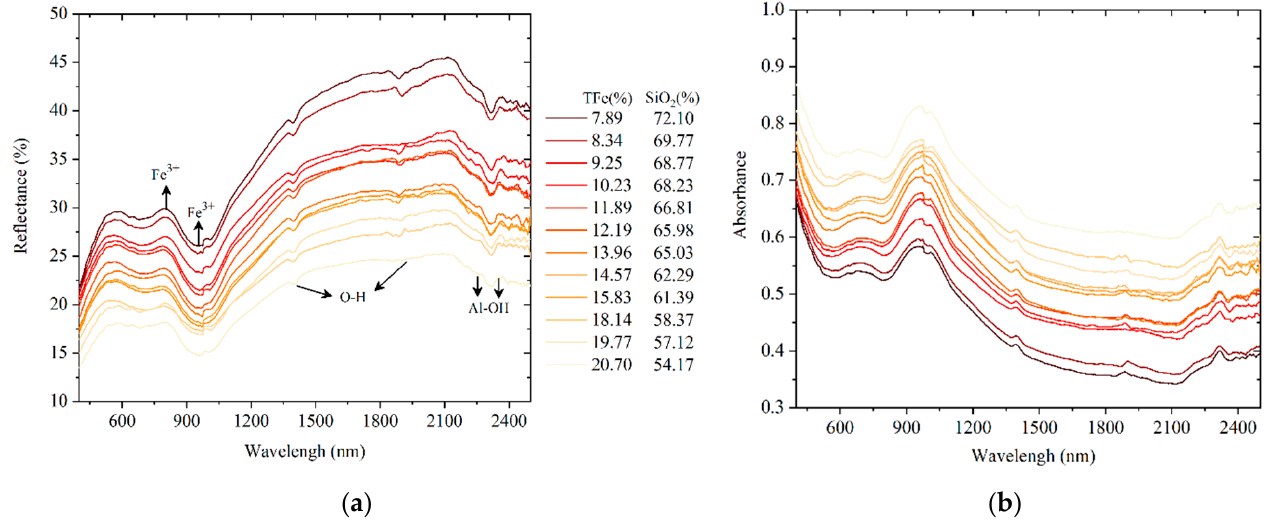
Figure 4. ( a ) The reflectance spectra of TFe and SiO 2 . ( b ) The absorbance spectra of TFe and SiO 2 in VIS–NIR.